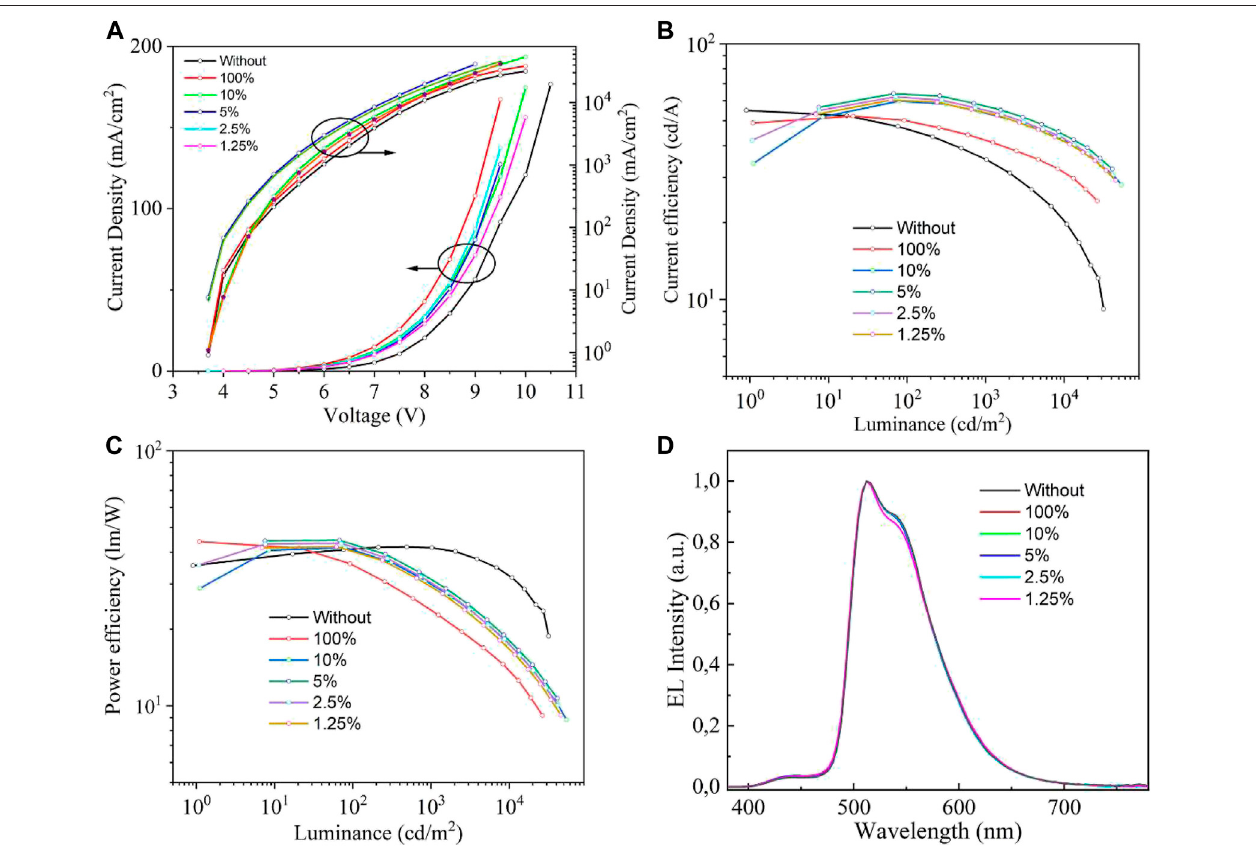
FIGURE6| ThegreenphosphorescentOLEDdevicewithhybridPEDOT:PSS/ZnSQDs fi lmastheHIL. (A) Currentdensity-voltage-brightness ( J - V - L ), (B) Current ef fi ciency-luminance (CE- L ), (C) Power ef fi ciency-current density (PE- J ) and (d) EL spectra at 6 V of the resulting devices with different concentrations.